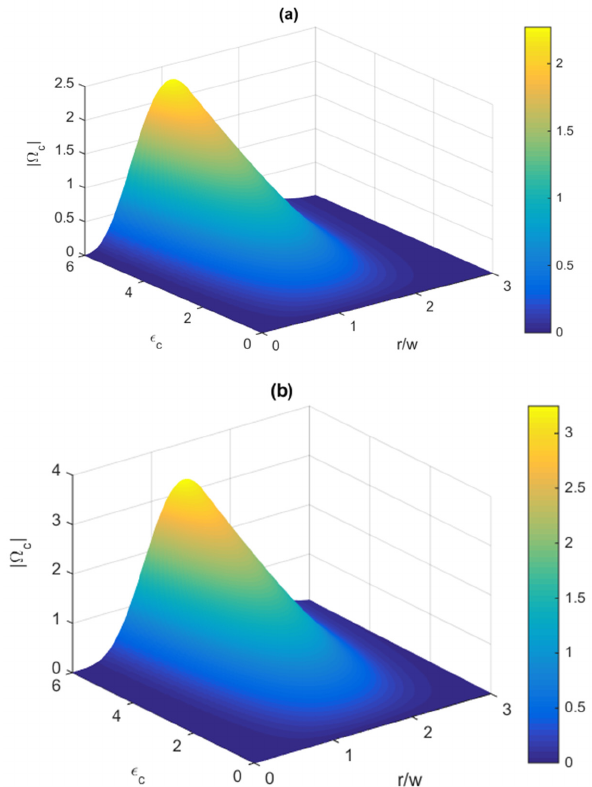
Figure 3. Intensity of coupling field | Ω c | as functions of r/w and ε c for ( a ) l c = 1 and ( b ) l c = Figure 3. Intensity of coupling field c Ω as functions of r / w and c l 4 = . c